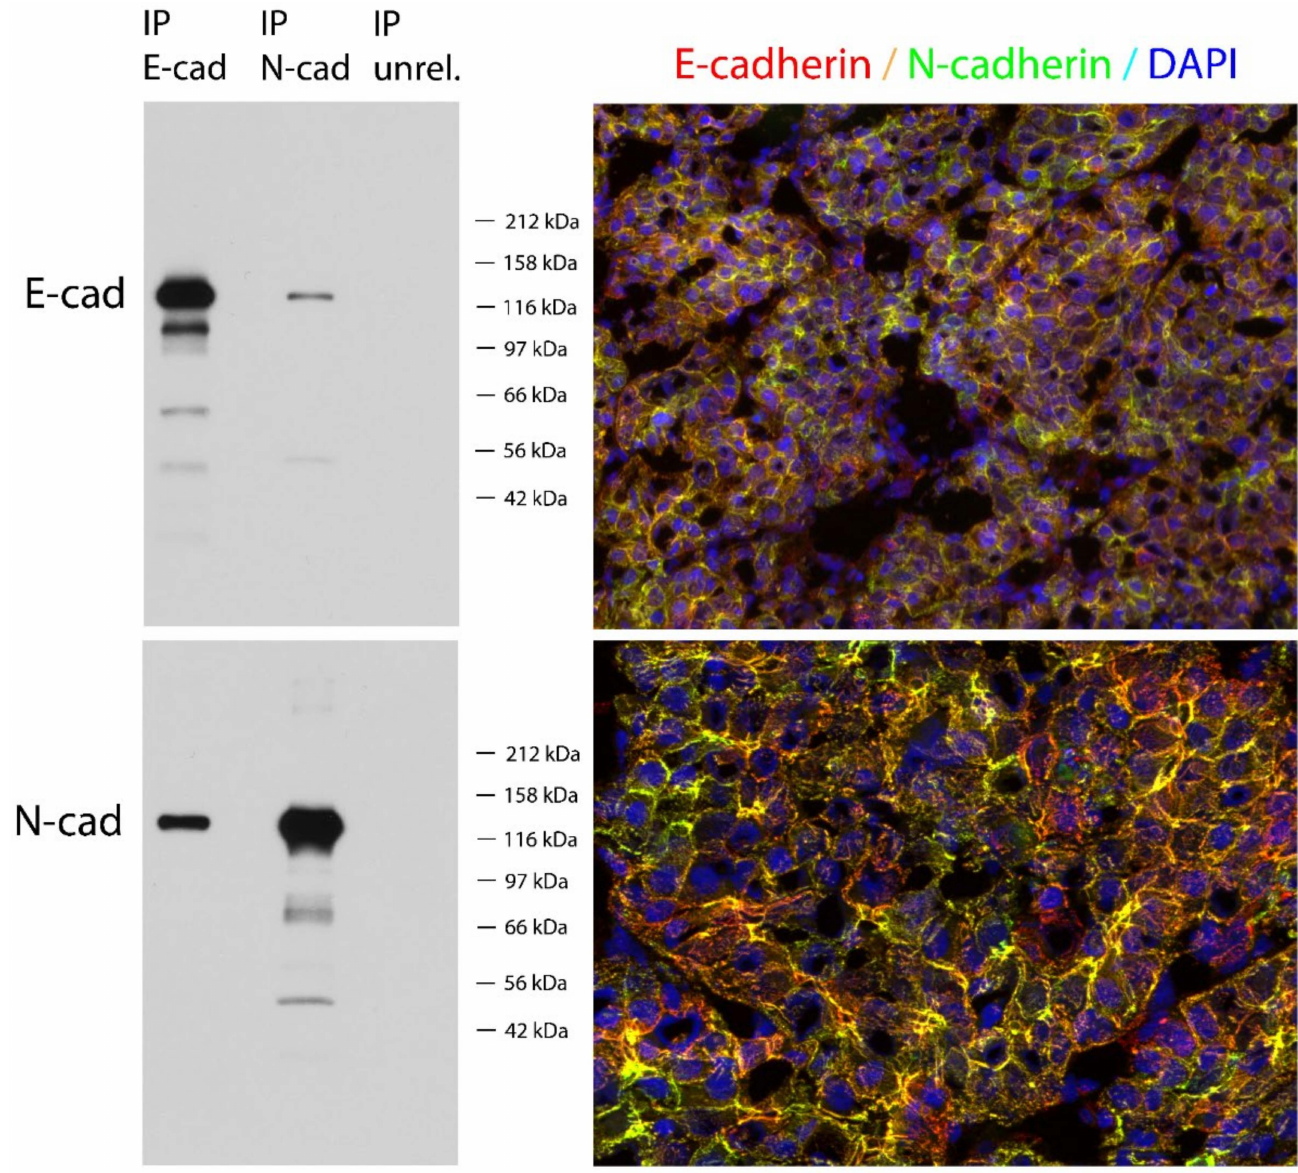
Figure A2. E- and N-cadherin coimmunoprecipitates in human HCC, as demonstrated by immuno- precipitation, SDS-PAGE (8%), and immunoblotting. Immunoprecipitation was performed with antibodies against E- and N-cadherin and an unrelated antibody from tissue lysates of cryopreserved human HCC, grade 2. In immunoblots of respective co-IPs, E- and N-cadherin were detected, but not in coimmunoprecipitations of unrelated antibodies, suggesting E:N-cadherin heterodimers. Molec- ular weight markers are depicted on the right side. On the right side, laser scanning fluorescence microscopy of E- and N-cadherin in the respective grade 2 HCC shows near-complete colocalization of E-cadherin (cy3, red) and N-cadherin (Alexa 4888, green; cell nuclei. DAPI,